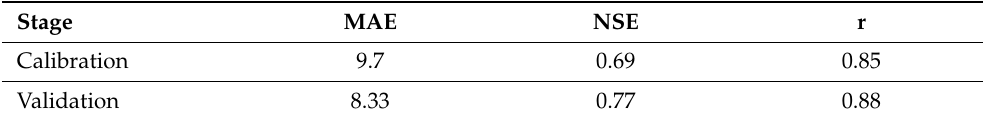
Table 3. Outcomes of the applied metrics to the MISD model.